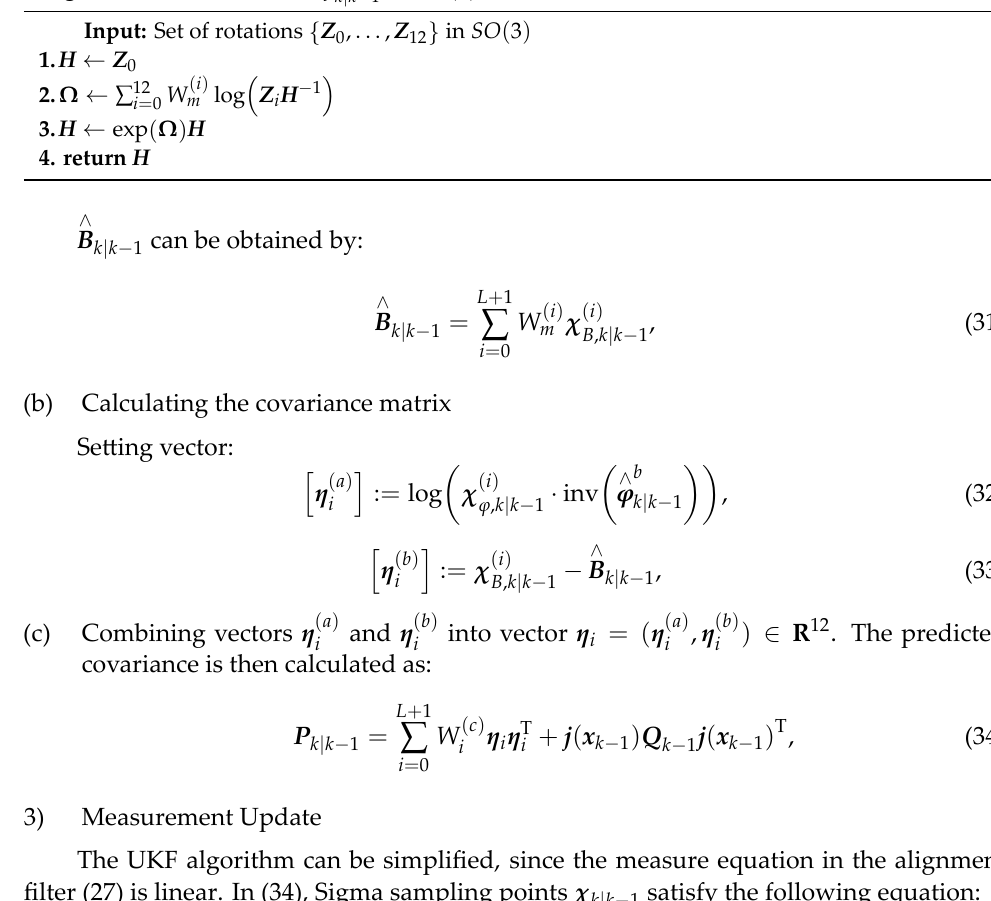
Algorithm 1: Calculation of